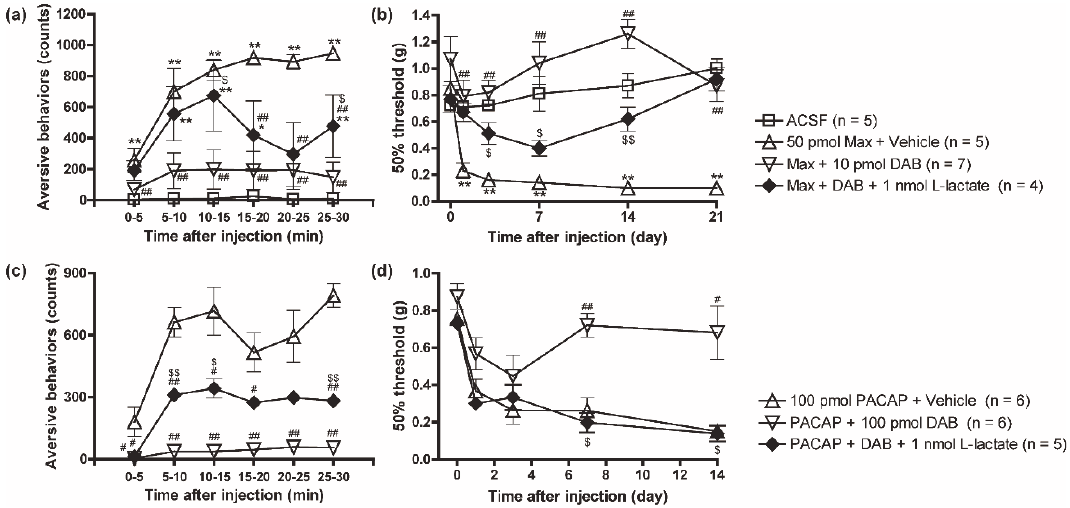
Figure 2. Simultaneous injection of L-lactate reversed the inhibitory effects of DAB on the PAC1 receptor-induced nociceptive behaviors. Intrathecal co-administration of L-lactate (1 nmol) with DAB (10 or 100 pmol) reinstated Max ( a , b ) and PACAP ( c , d ) induced aversive behaviors ( a , c ) and mechanical allodynia ( b , d ). * p < 0.05 and ** p < 0.01 when compared with ACSF data. # p < 0.05 and ## p < 0.01 when compared with Max + Vehicle in ( a ) and ( b ) or PACAP + Vehicle in ( c ) and ( d ). $ p <